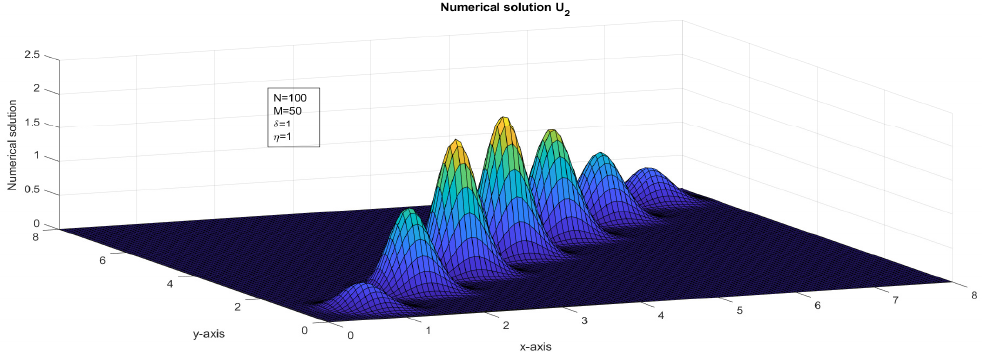
Figure 11. The surface plot illustrates the numerical solution, U 1 , for Case 1 in Example 1.